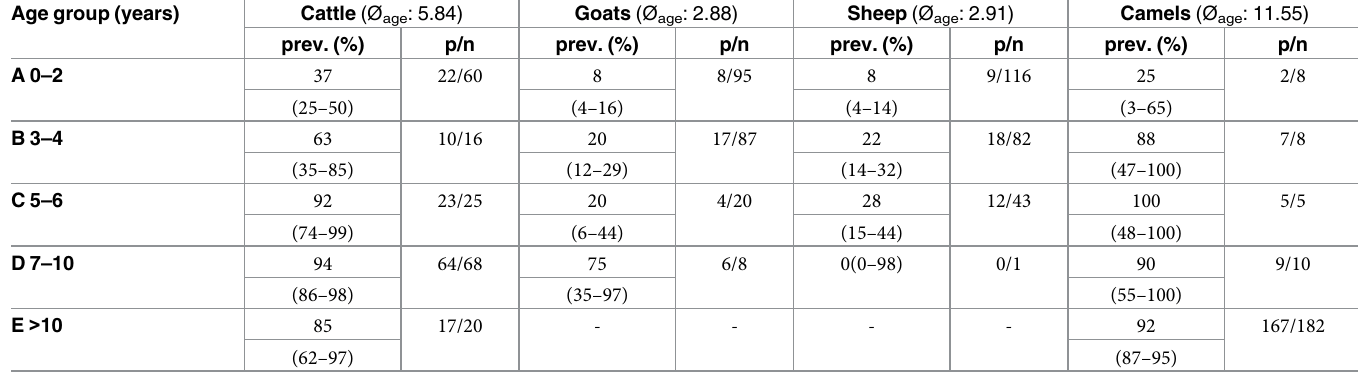
Table 3. Age-related prevalence of IgG-specific CCHFV antibodies in cattle, goats, sheep and camels.